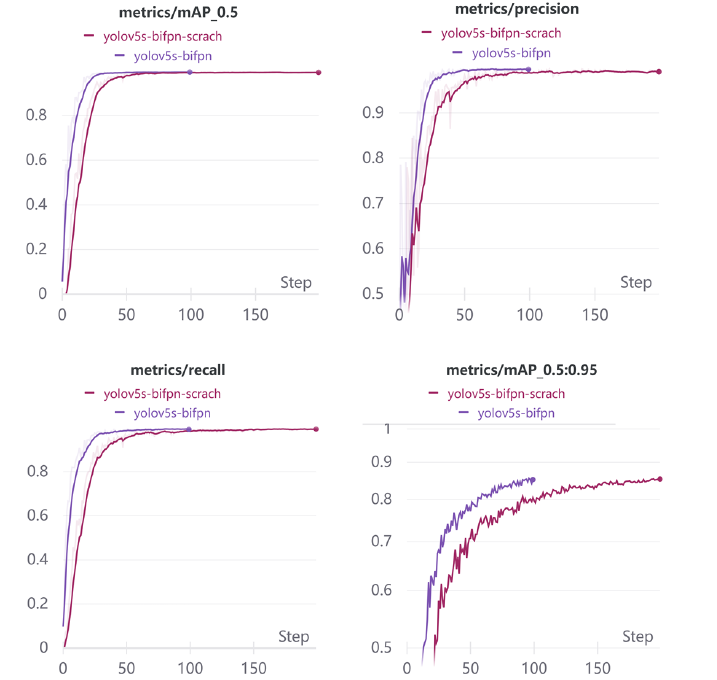
Figure 18. Training process with